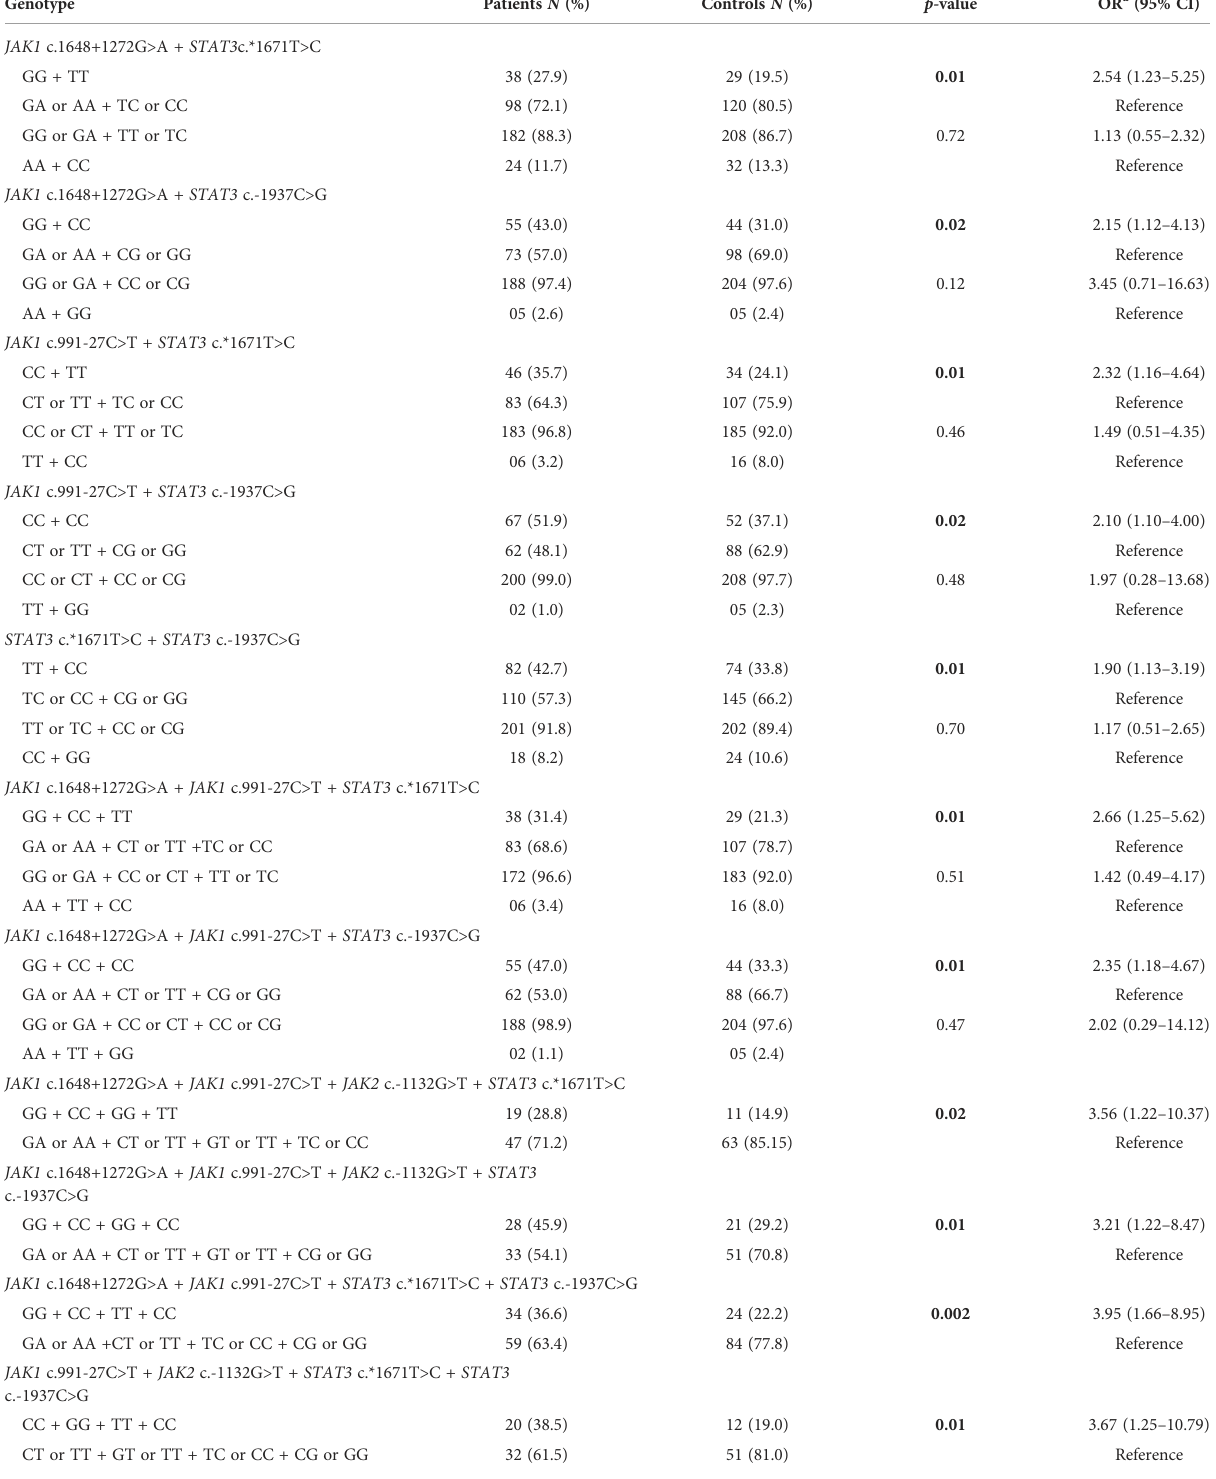
TABLE 3 JAK1 , JAK2 , and STAT3 signi fi cant combined genotypes in 248 cutaneous melanoma patients and 274